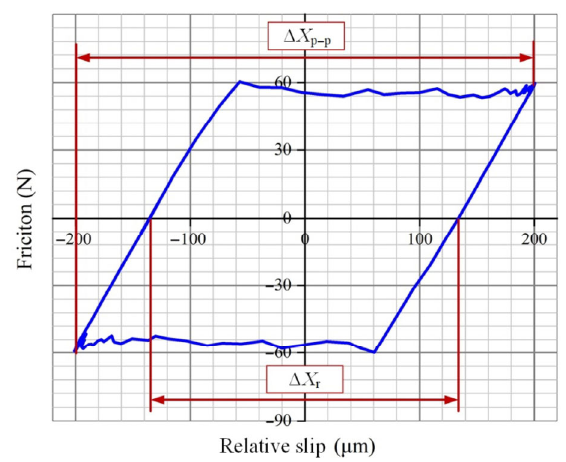
Fig. 6 Friction force–hysteresis loop